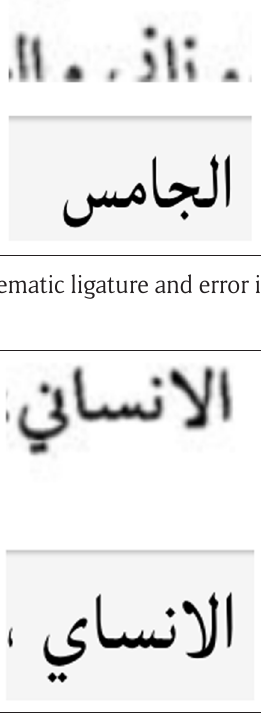
Figure 11: Atypical dot